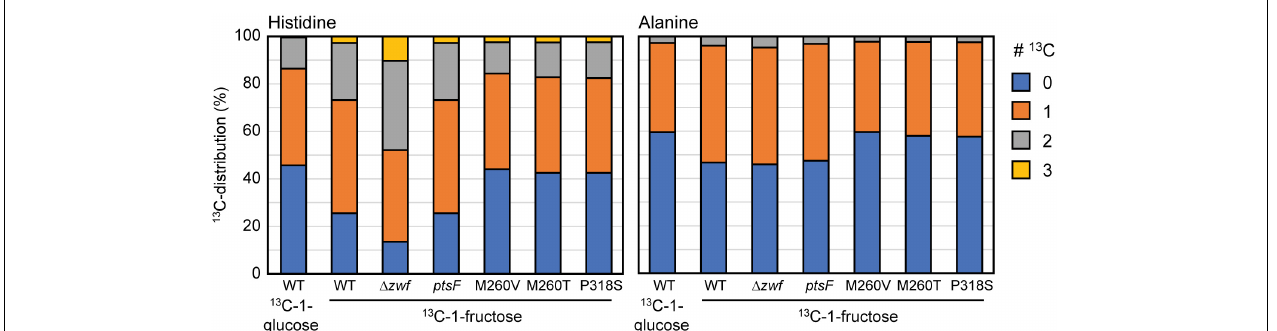
relative oxPPP flux when fructose was catabolized via PtsF. On the other hand, (cid:49) ptsF (cid:49) ptsG strains overexpressing the